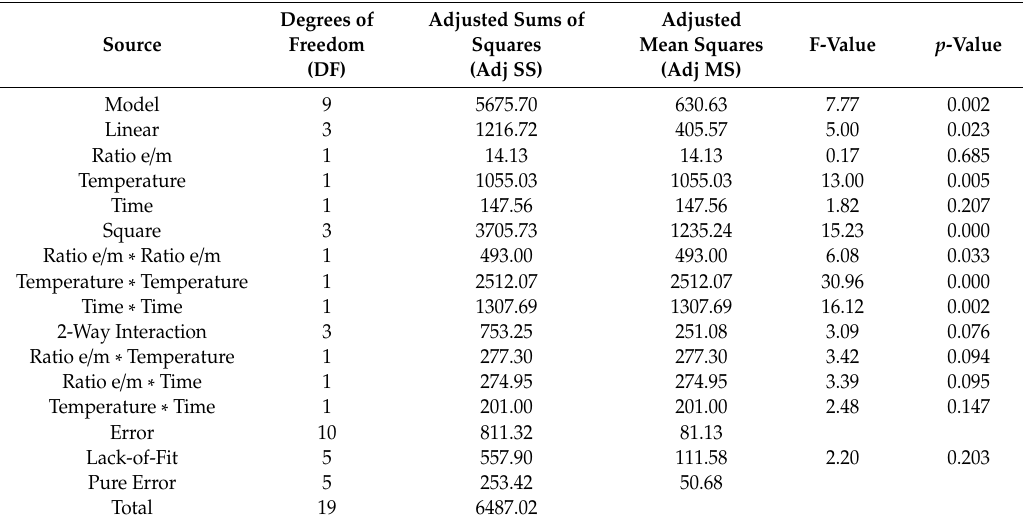
Table 2. Analysis of variance for resveratrol